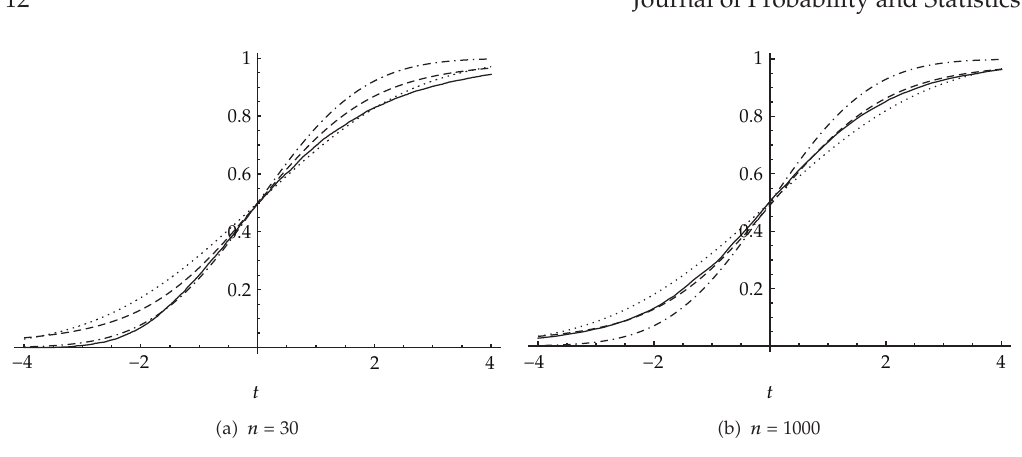
√ n (cid:7) (cid:12) θ n − θ (cid:8) obtained via Monte Carlo simulations. ≤ t (cid:8) , where T ∼ Q . Values θ (cid:6) 1, x (cid:6) 2, n (cid:6) 5, σ (cid:6) . 5, 3 3 1 1